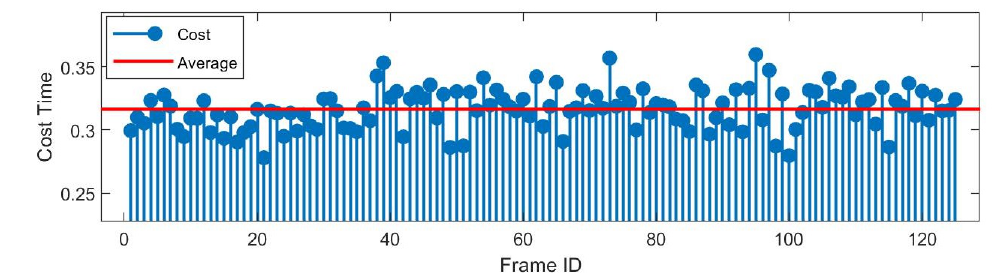
Figure 10. Time-consumption result of 120 triggered frames on KITTI 00. In the case of triggering re-identification, the average time consumption of the whole system is 0.316 s.